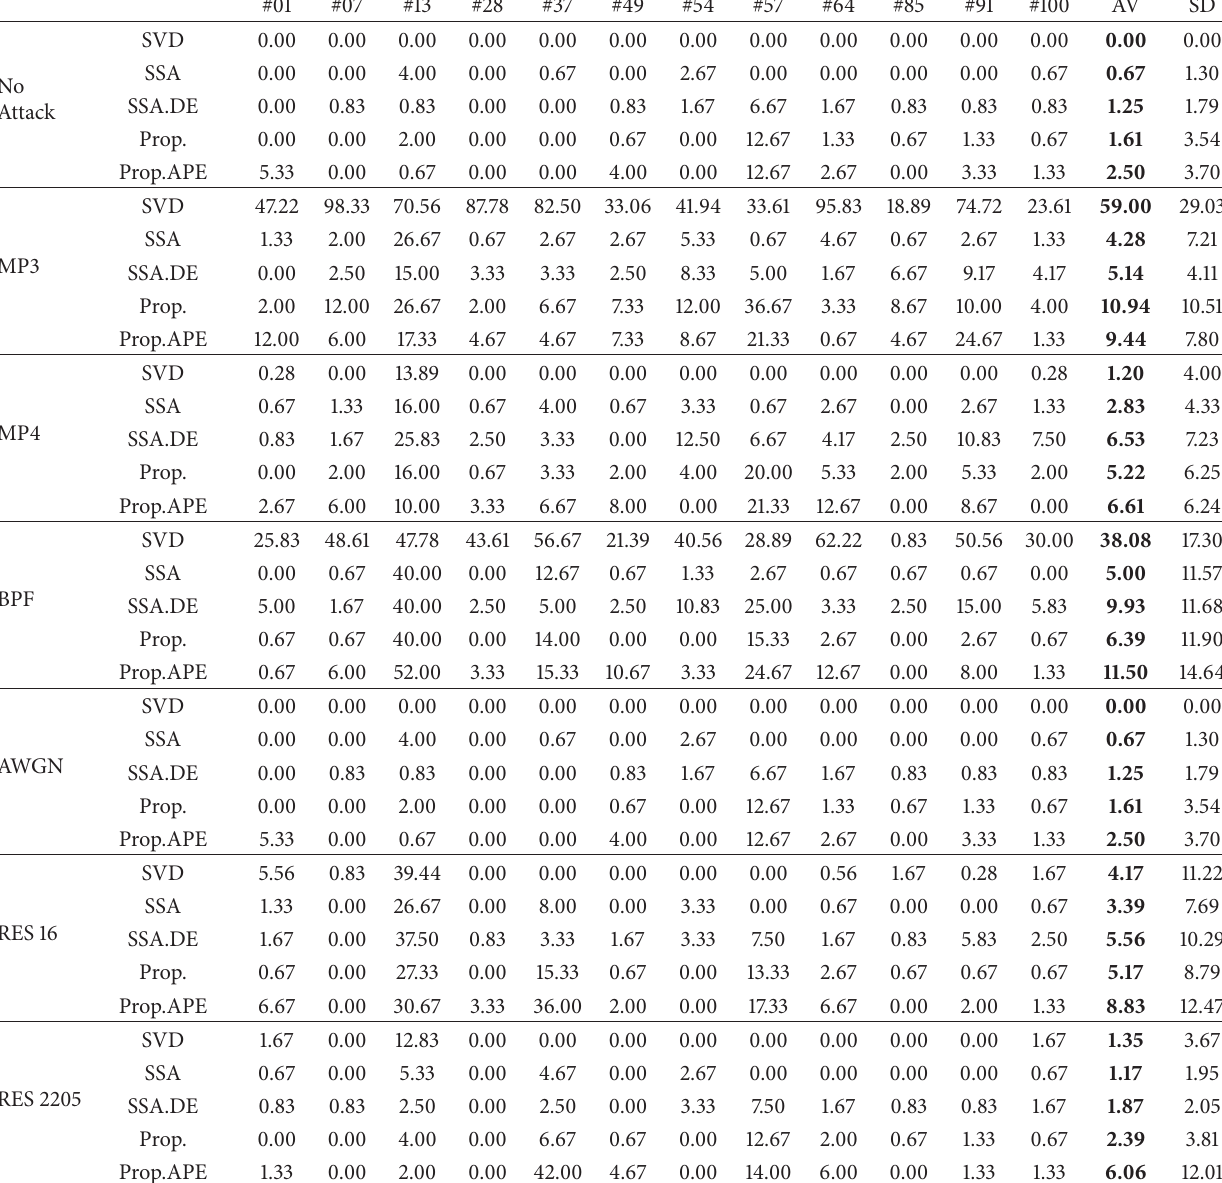
Table 5: Robustness evaluation using BERs (%): comparison of the conventional SVD-based method (SVD) [23], SSA-based scheme (SSA) [28], SSA-based scheme with the differential evolution (SSA.DE) [29], proposed scheme without the automatic parameter estimation (Prop.), and proposed one with the automatic parameter estimation (Prop.APE) when attacks (i.e., MP3 and MP4 compression, white-Gaussian-noise addition (AWGN), resampling with 16 and 22.05 kHz (RES 16 and RES 22.05, resp.), and band-pass filtering (BPF)) were performed. AV and SD are average and standard deviation,